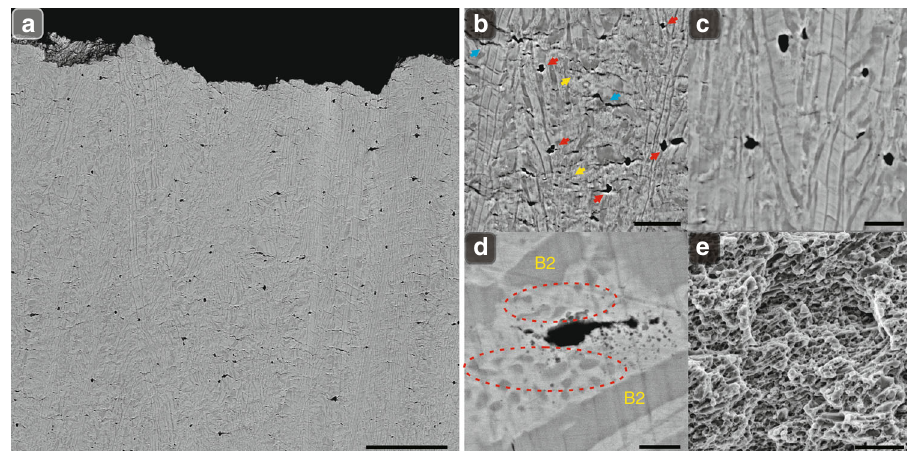
Fig. 4 Typical SEM images of damage-evolution mechanisms for the hierarchical DPHL HEA at the late stage of deformation. a Microcrack distribution near the fractured end. b Multiple microcracks mainly including circle-like, tortuous, and even submicron cracks (indicated by red, blue, and yellow arrows, respectively). c At strains of 17 – 20%, the circle-like microcracks with blunted crack-tips, whose propagation remains con fi ned by adjacent ductile components. d High-magni fi cation SEM image indicating that these circle-like cracks are initially nucleated predominantly in FCC lamellae and caused by the limited deformation ability of P2 (the intergranular B2 phase, marked by dashed red circles), which are revealed at the strain of ~17%. e Fractography of the fracture surface with massive dimples, providing an indirect explanation for the enhanced ductility. Scale bars, 50 µ m in a , 10 µ m in b , 5 µ m in c , 1 µ m in d , and 5 µ m in e